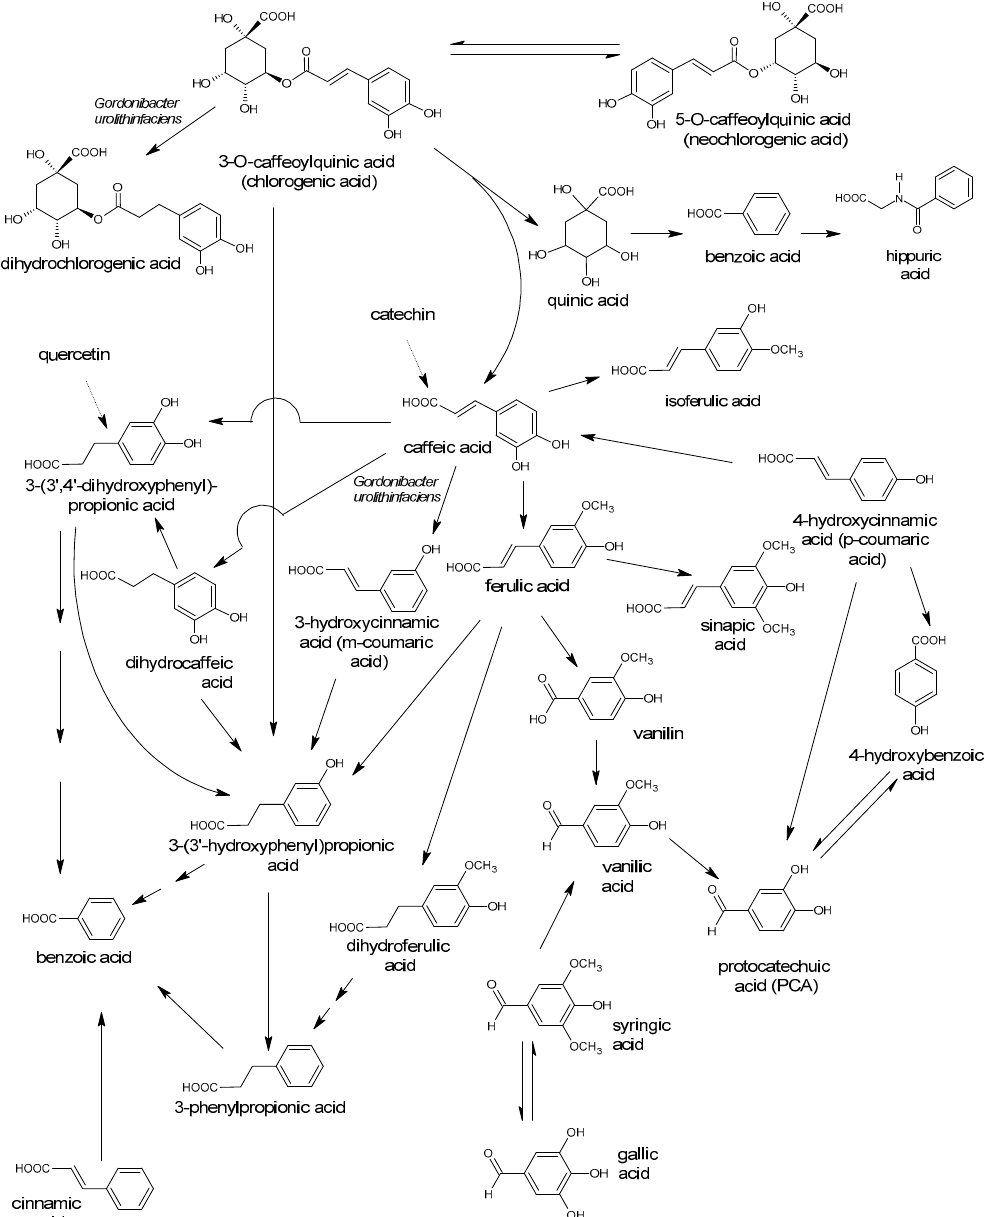
Figure 18. Pathways of some phenolic acid metabolism conducted by various bacteria. Based on [37,304,312–315]. Incubation of coffee samples (a rich source of phenolic acids) with the human fecal microbiota led to the rapid metabolism of chlorogenic acid and the production of dihy- drocaffeic acid and dihydroferulic acid, while caffeine remained unmetabolized [316]. Caffeic acid esters can be rapidly transformed to 3-(3 ′ -hydroxyphenyl) propionic acid by human fecal microbiota [304] by de-esterification followed by a reduction of a double bond and dehydroxylation at the C4 position (Figure 18). Monteiro et al. [317] revealed that the main chlorogenic acid metabolites identified in urine after coffee consumption were: dihydrocaffeic, gallic, isoferulic, ferulic, vanillic, caffeic, 5 -O- caffeoylquinic, sinapic, 4-hydroxybenzoic, and p -coumaric acids, with gallic and dihydrocaffeic acids being the